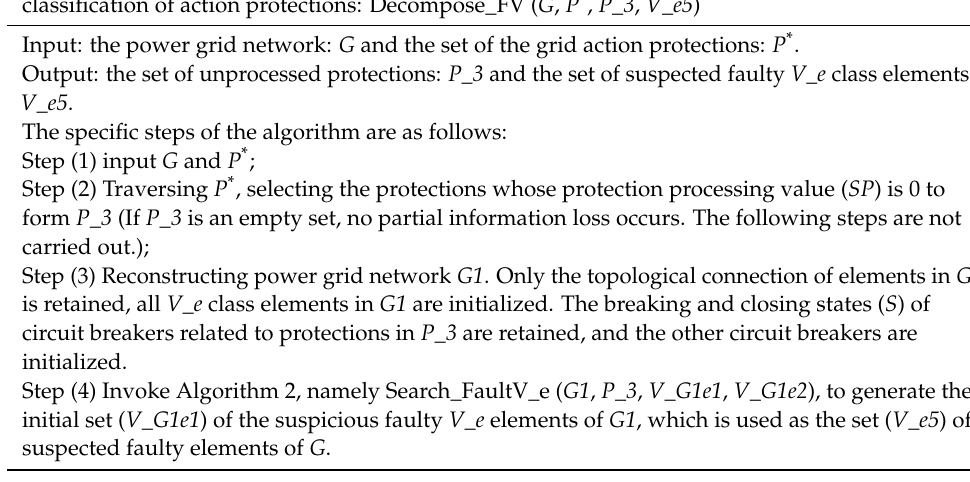
Algorithm 4 Power grid decomposition and suspected faulty elements search based